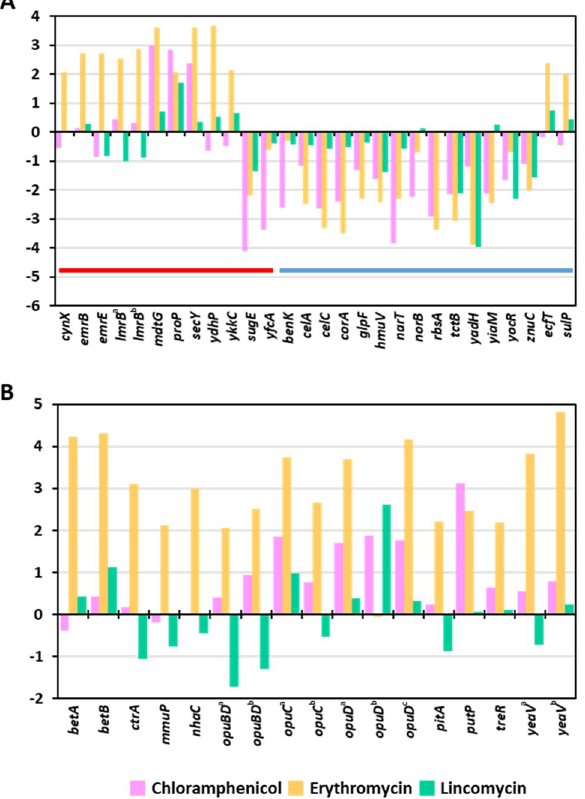
Figure 2. Log 2 fold-change values for genes related to ( A ) efflux and transporters, and ( B ) salt tolerance, on treatment of S. equorum strain KM1031 with chloramphenicol, erythromycin and lincomycin, respectively. Color code: red: efflux-related genes, blue, transporter-related genes.